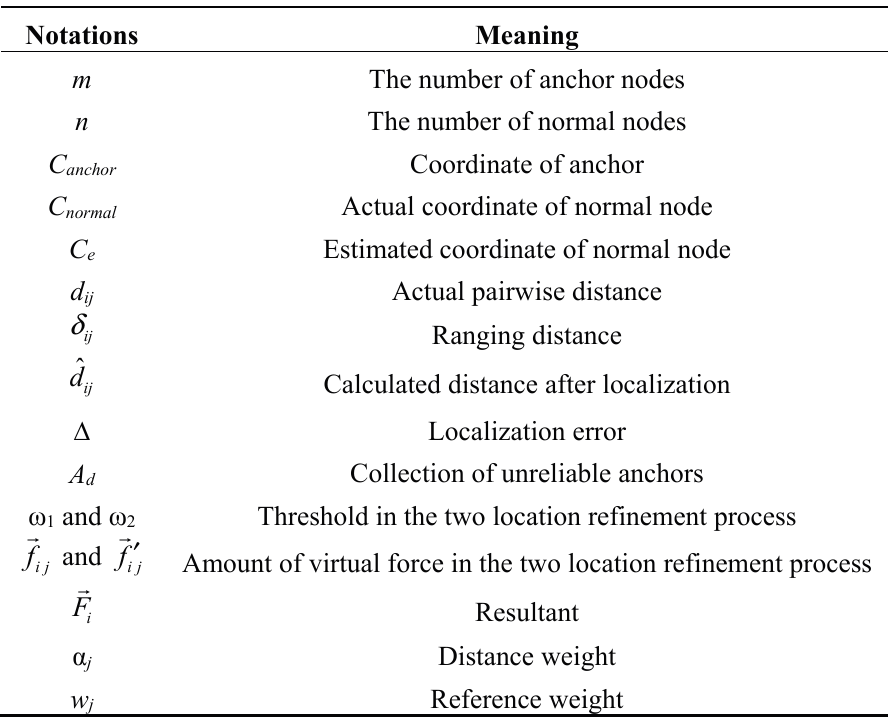
Table 1. Notation